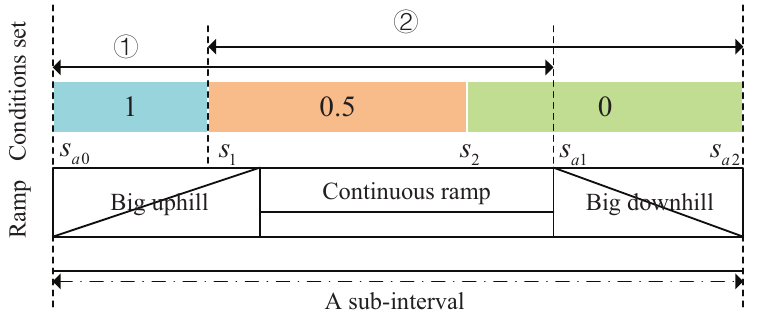
Figure 3. Initialization settings of the operating conditions for the